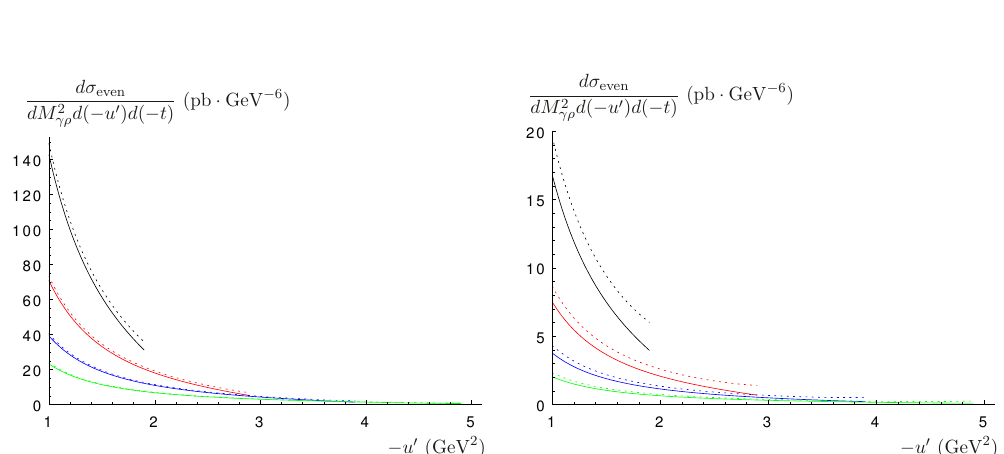
Figure 9 . Differential cross section for a photon and a longitudinally polarized ρ meson production, for the proton (left) and the neutron (right), as a function of − u ′ , for M 2 in black, red, blue, green). Solid: “valence” model, dotted: “standard” model.